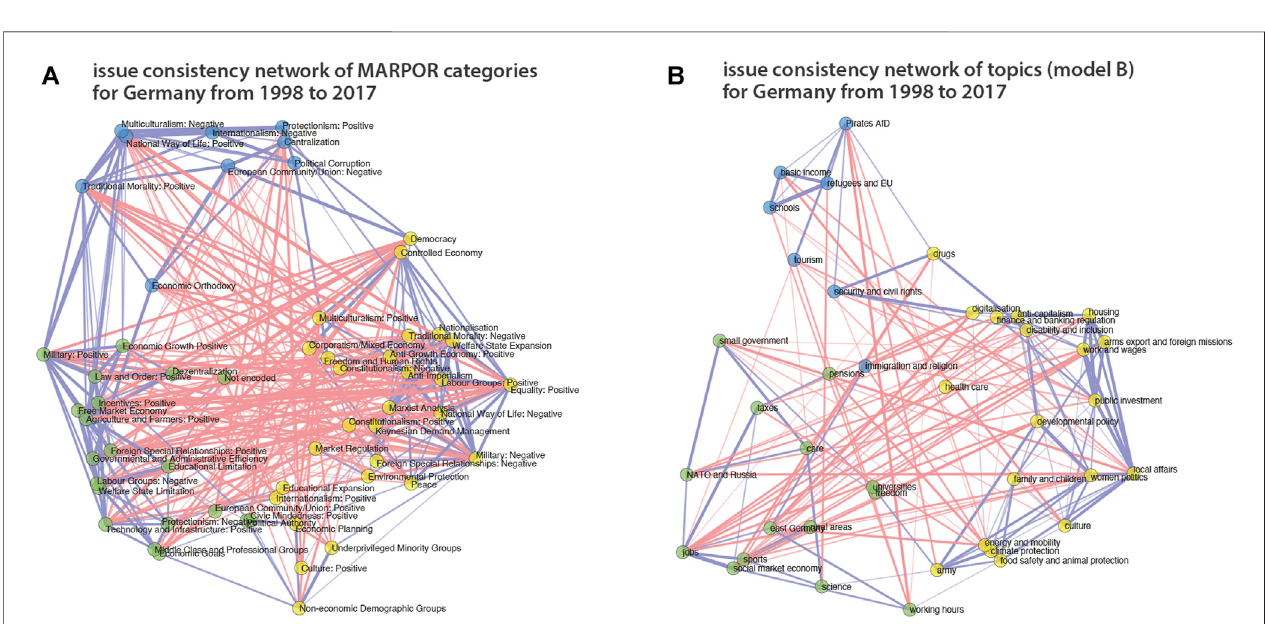
FIGURE 5 | IICNs for categories (A) and topics (B) for Germany from 1998 to 2017. Edges between categories or topics are shown if their correlation is signi fi cant at the 5% level ( p < 0.05). Edge widths represent the strength of the correlations. The issue bundles that maximize coherence are marked by node color.